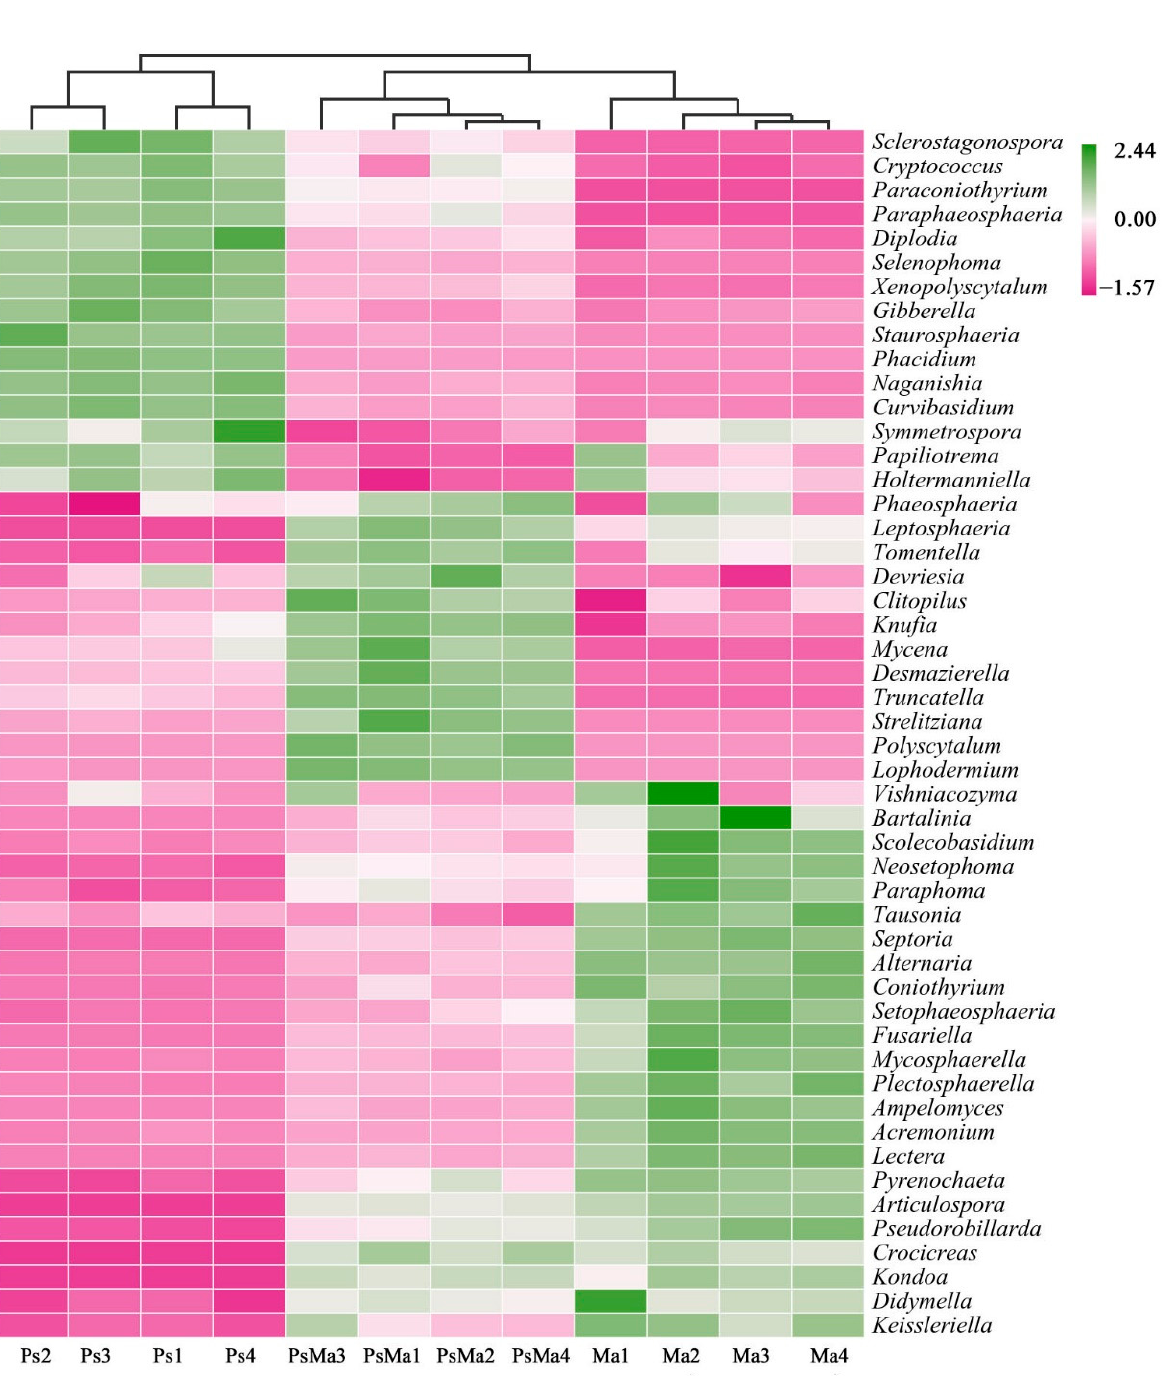
Figure 8. Heatmap and cluster analysis based on relative abundance of the top 50 genera identified in litter fungal communities. The samples are grouped according to their similarity to each other. In the figure, pink represents the genus with lower abundance in the corresponding sample, green represents the genus with higher abundance, and the color change represents the level of abun- dance. Ma: Morus alba ; PsMa: Pinus sylvestris var. mongolica × Morus alba ; Ps: Pinus sylvestris var. mongolica .